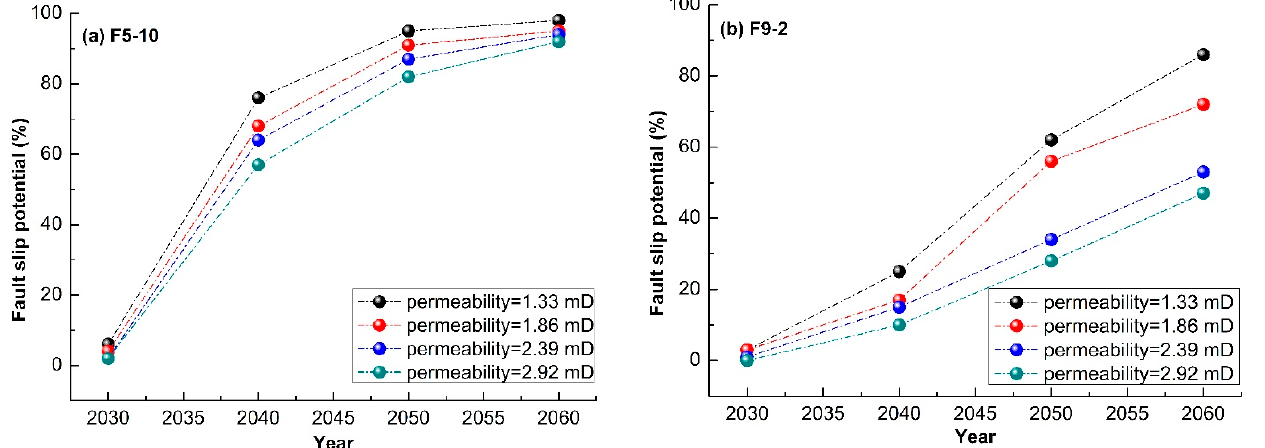
Figure 12. Changes in FSP on segments F5-10 ( a ) and F9-2 ( b ) with increasing